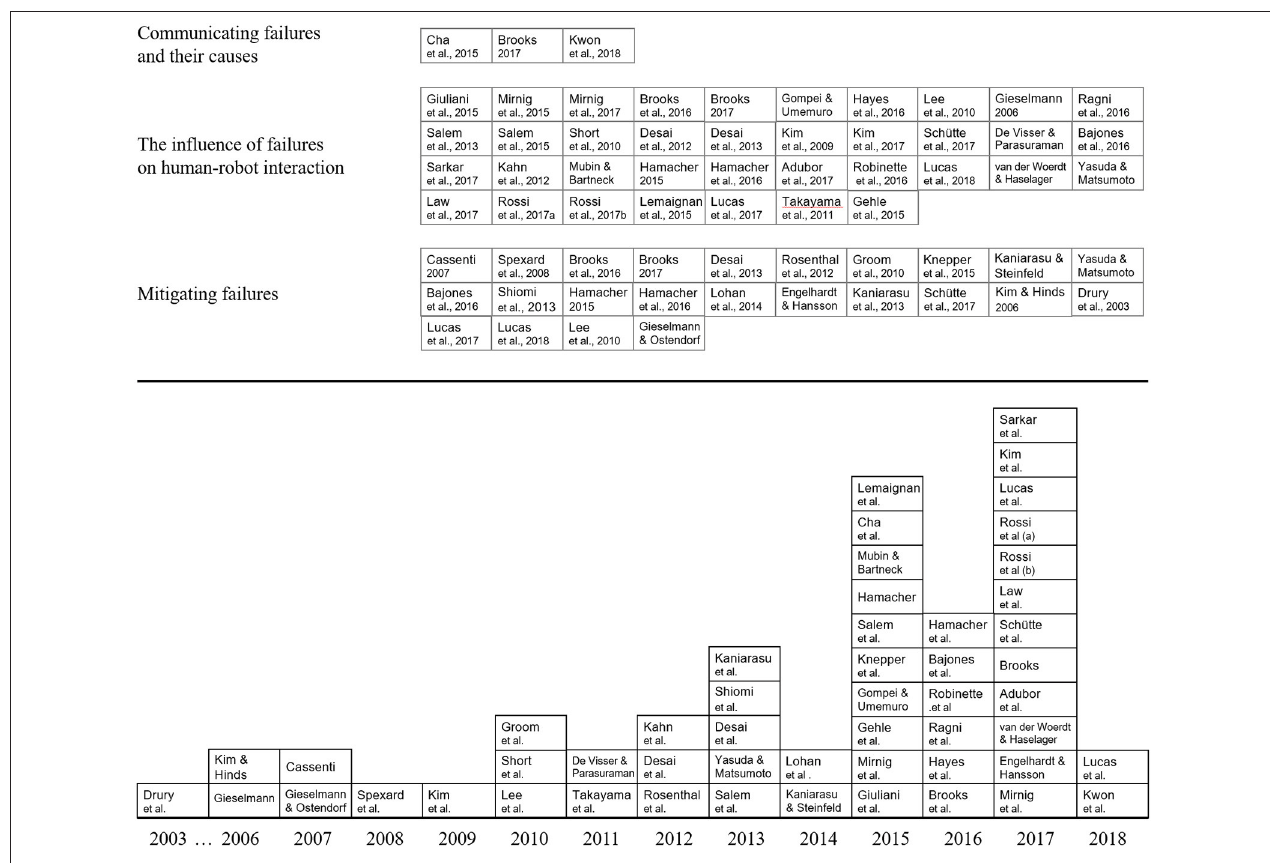
FIGURE 2 | Distribution of user-centered failure handling by topic ( Top ) and by publication year ( Bottom